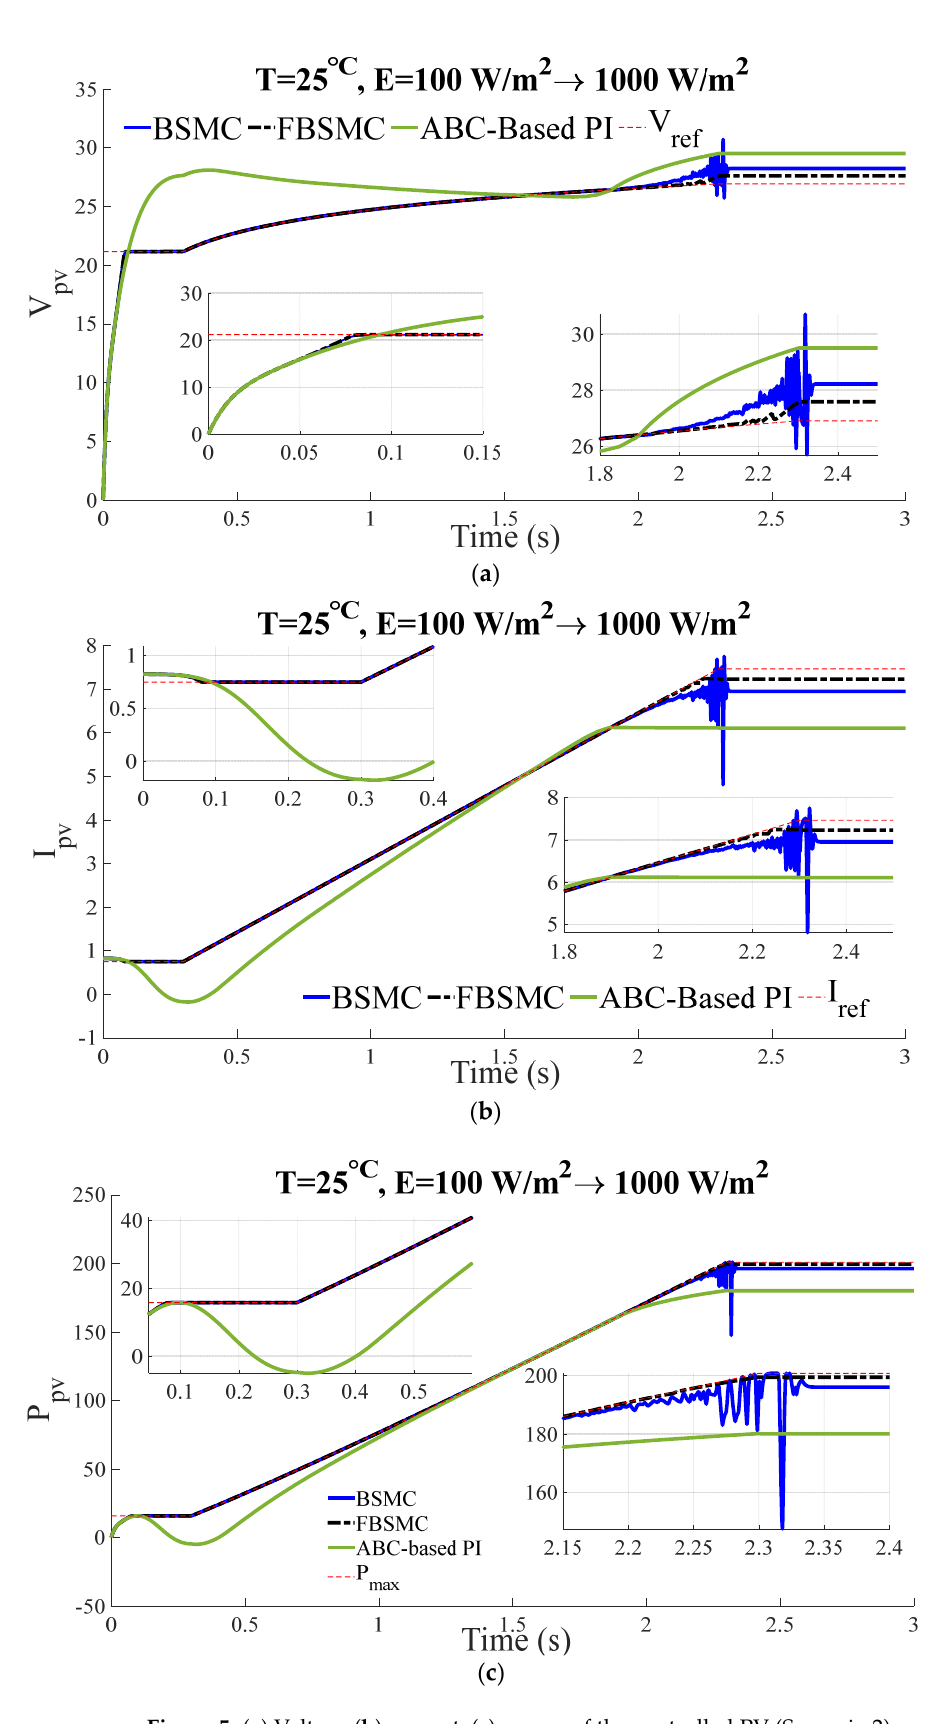
Figure 5. ( a ) Voltage ( b ) current, ( c ) power of the controlled PV (Scenario 2).